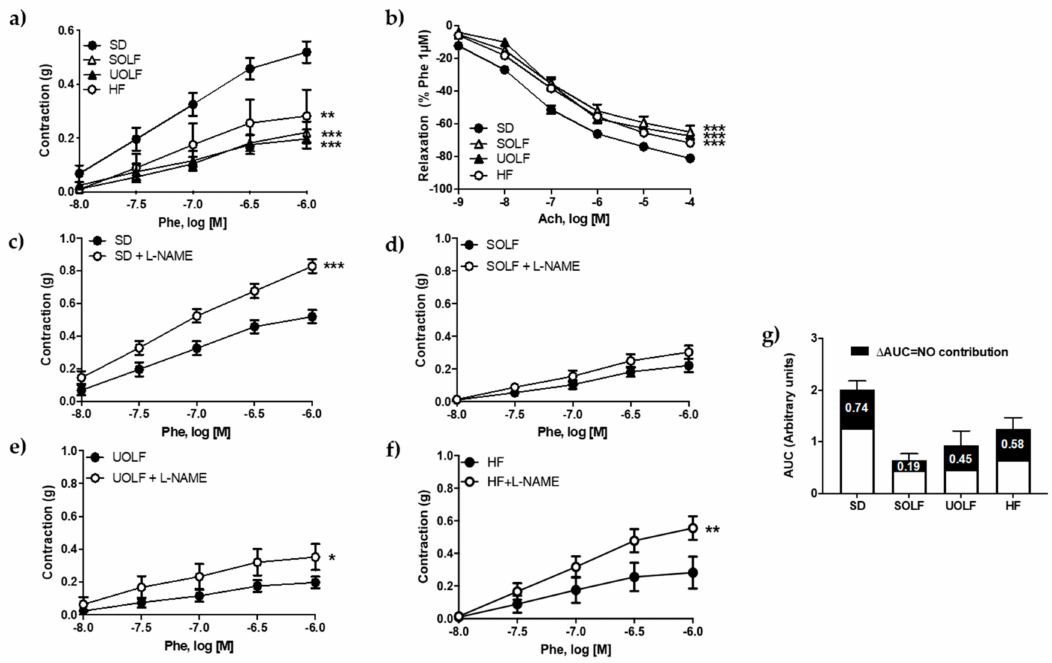
Figure 2. Characterization of vascular function. Concentration–response curves to ( a ) phenylephrine (Phe, 10 − 8 to 10 − 6 M) and ( b ) acetylcholine (Ach, 10 − 9 to 10 − 4 M) in aorta segments from standard (SD), unsaturated oil-enriched Food (UOLF), saturated oil-enriched Food (SOLF), and high-fat (HF) mice. Contractions are expressed in absolute values and relaxant responses are expressed as percentage of a previous contraction to Phe (10 − 6 M). Concentration–response curves to Phe (10 − 8 to 10 − 6 M) in aorta segments from SD ( c ), SOLF ( d ), UOLF ( e ), and HF mice ( f ) in absence and presence of L-NAME. ( g ) AUC in response to Phe in presence (full histogram) or absence (white bar) of L-NAME. The difference in AUC (black bar) represents NO bioavailability. Data are shown as mean ± SEM of 7–10 animals per group. * p < 0.05, ** p < 0.01, *** p < 0.001 vs. its corresponding